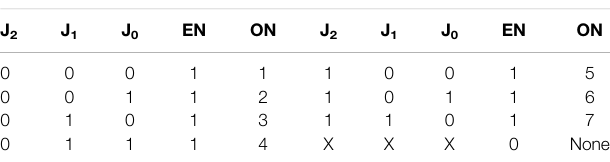
TABLE 1 | Signal numbering code.